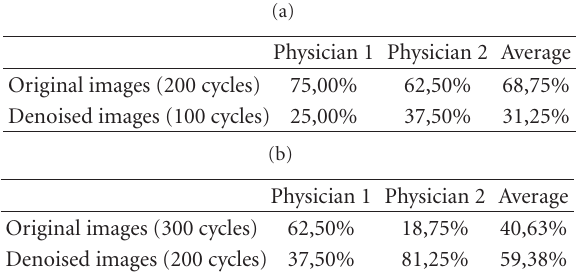
Table 4: Results of comparative